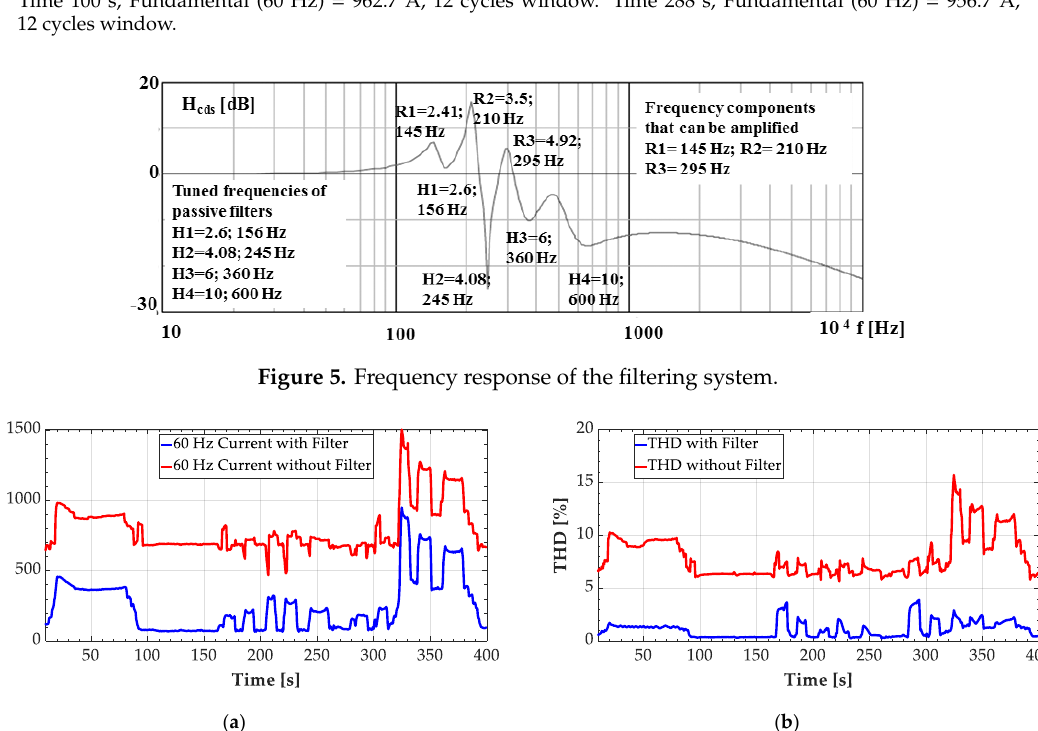
Table 4. Characteristics of protection relays.